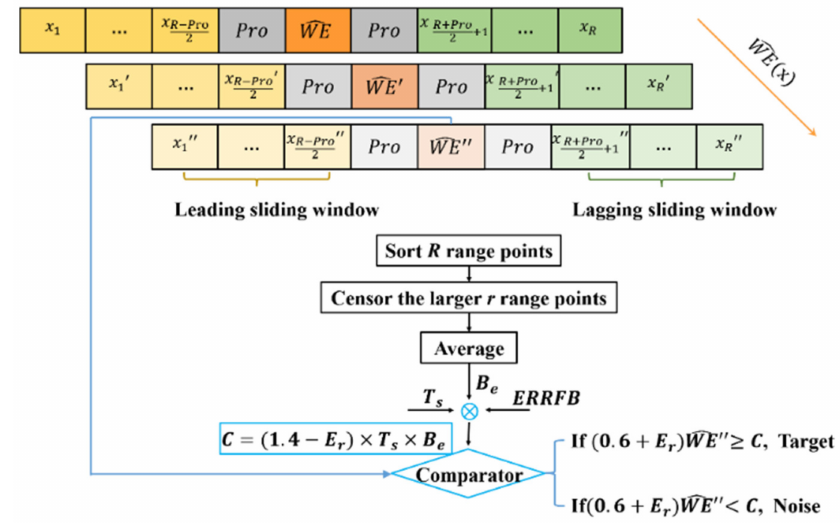
Figure 3. Illustration of the censored mean-level detector, constant false-alarm